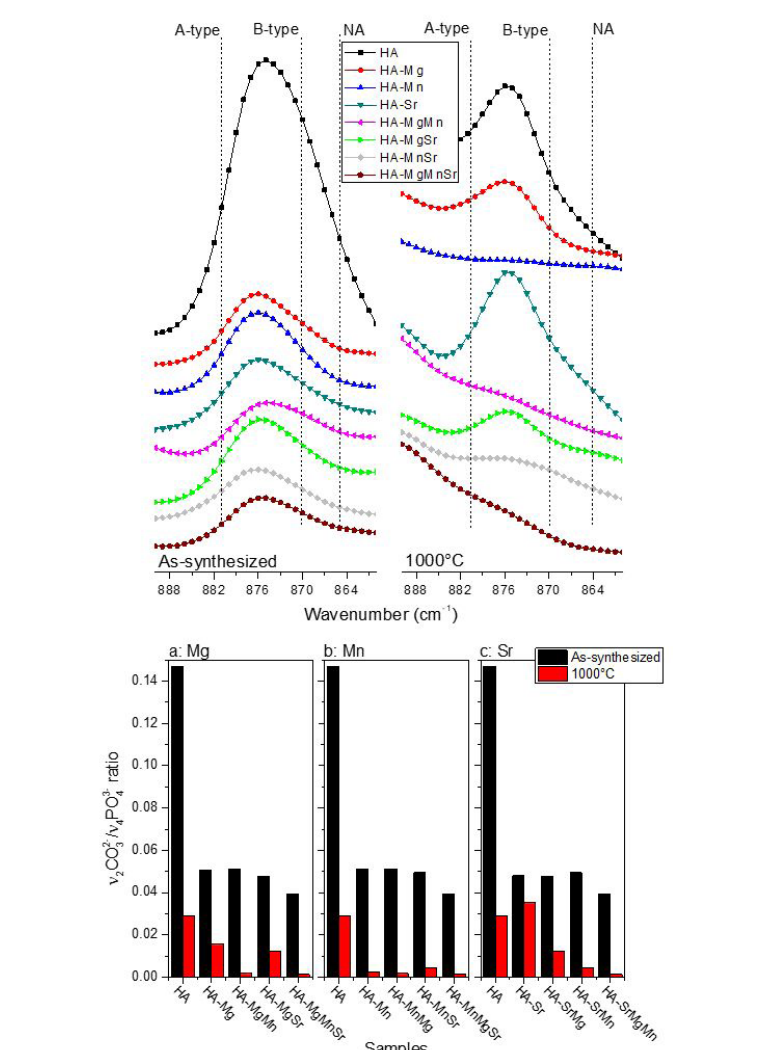
CO 32- and ν PO 43- absorption bands before and after calcination at 1000°C. The effect 2 4